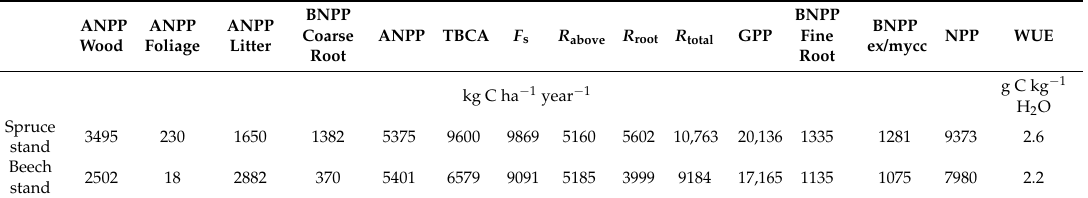
Table 7. Carbon allocation in spruce and beech stands (kg C · ha − 1 · year − 1 ).